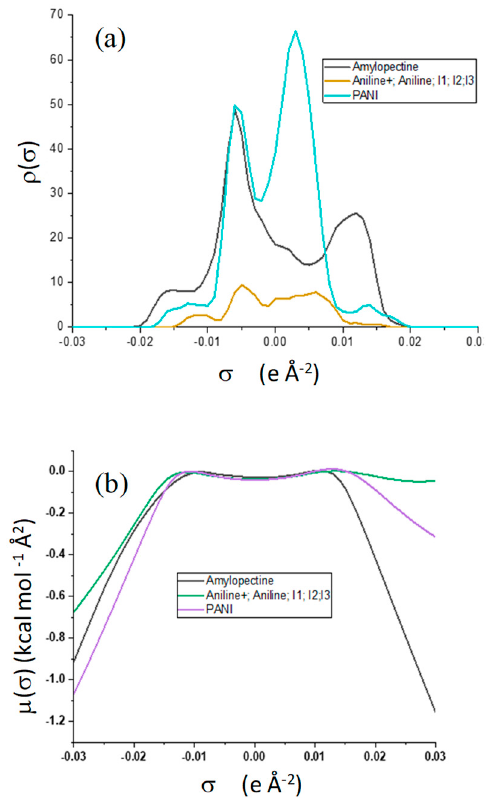
Figure 10. Interactions in PANI/starch biocomposites using COSMO-RS. Figure 10. σ -profile ( a ) and σ -potential ( b ) distributions of aniline, polyaniline, and amylopectin. The interaction energies reported in Table 12, reveal that the HB type contributes the most to the mixture’s energy ( − 31.33496 and − 40.29382 Ha). The PANI–amylopectin pair (ratio 1:1) achieves the highest value, while I2-amylopectin (ratio 3:1) has the lowest. The second contribution to the mixture’s energy is Van der Waals (between − 26.70916 and − 27.83387 Ha), with the minimum value for the PANI–amylopectin couple (1:1) and the maximum value for I2-amylopectin (3:1). The mixture’s energy ranges from − 55.25390 for I2-amylopectin (3:1) to − 63.51928 Ha for PANI–amylopectin (Emisfit). Table 12. Interaction energies of amylopectin with the various compounds, which are depicted in Figure 11.